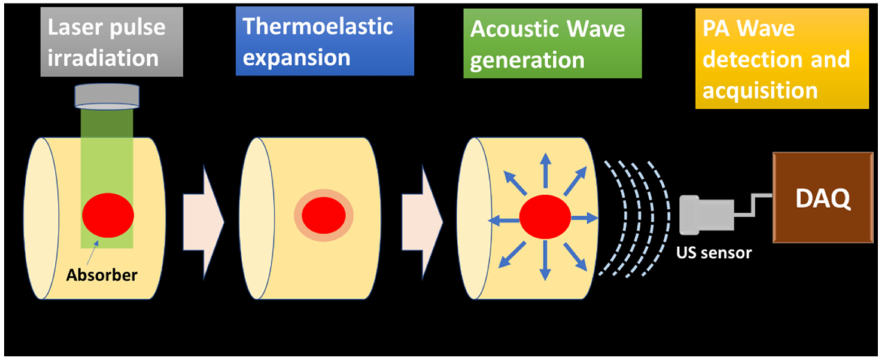
Figure 1. PA wave generation and propagation